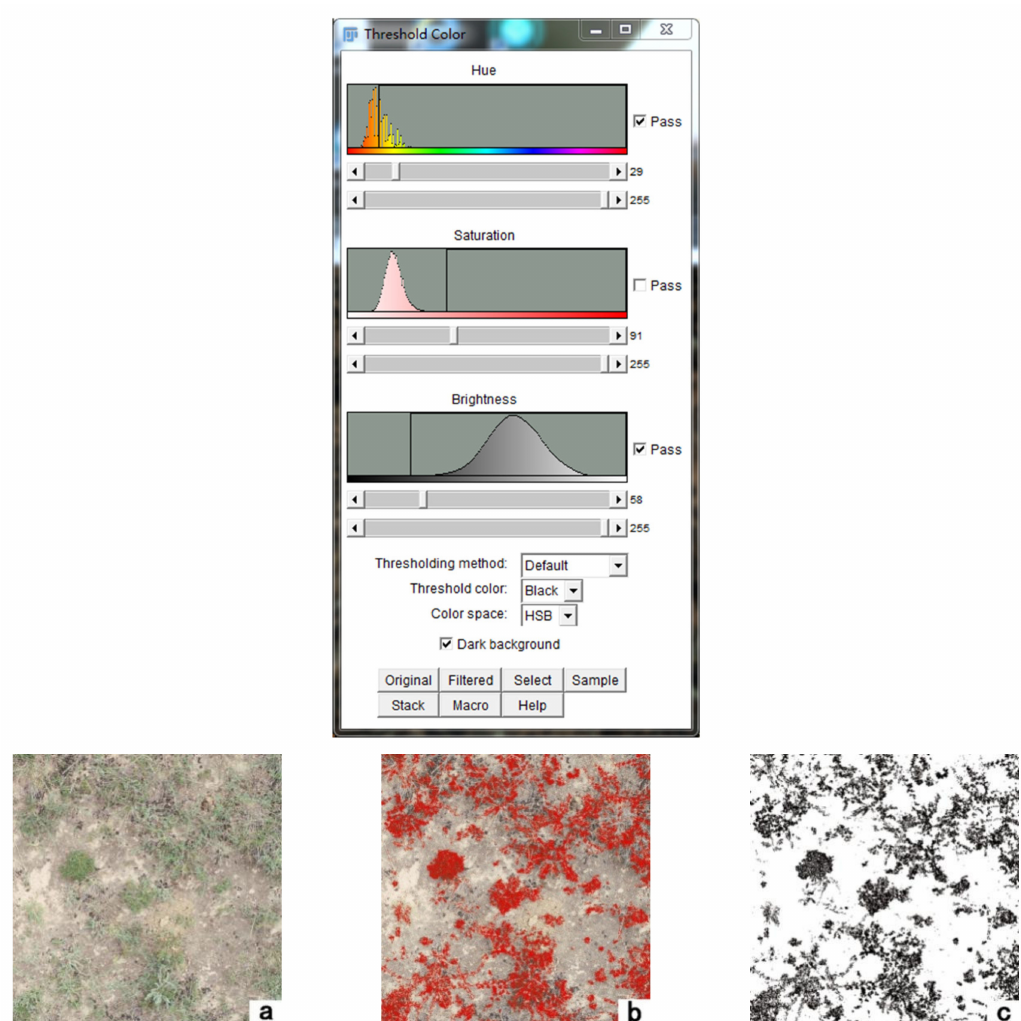
Figure5. TheHSB(hue, saturation, andbrightness)settingofobtainingvegetationcoverage. ( a )Original UAV visible image; ( b ) final selected portion; ( c ) result of the vegetation coverage